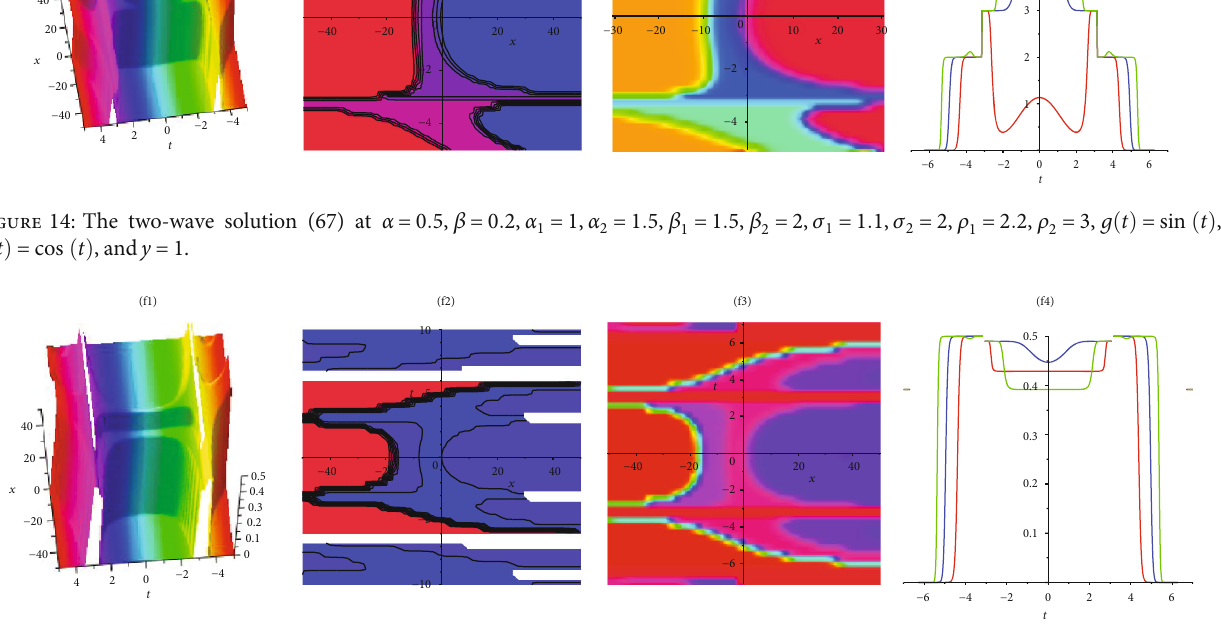
= 2, β = 3 : 2, σ = 1 : 1, σ = 2, σ = 1 : 5, ρ = 1 2 3 2 3 1